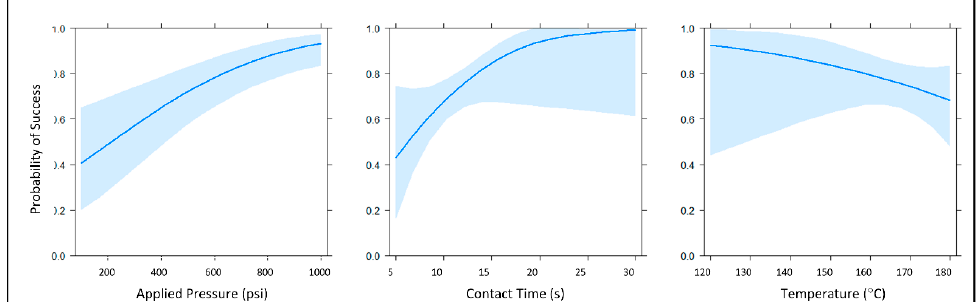
Figure 5. Main effect plots of the selected generalized linear model. The main effects for this model were the continuous predictor variables applied pressure, temperature, and contact time (power + height + time). Each of these marginal effects plots reflects the probability of successful channel closure when the other predictor variables are held constant at their respective means. Light blue traces indicate a 95% confidence interval for each probability plot.